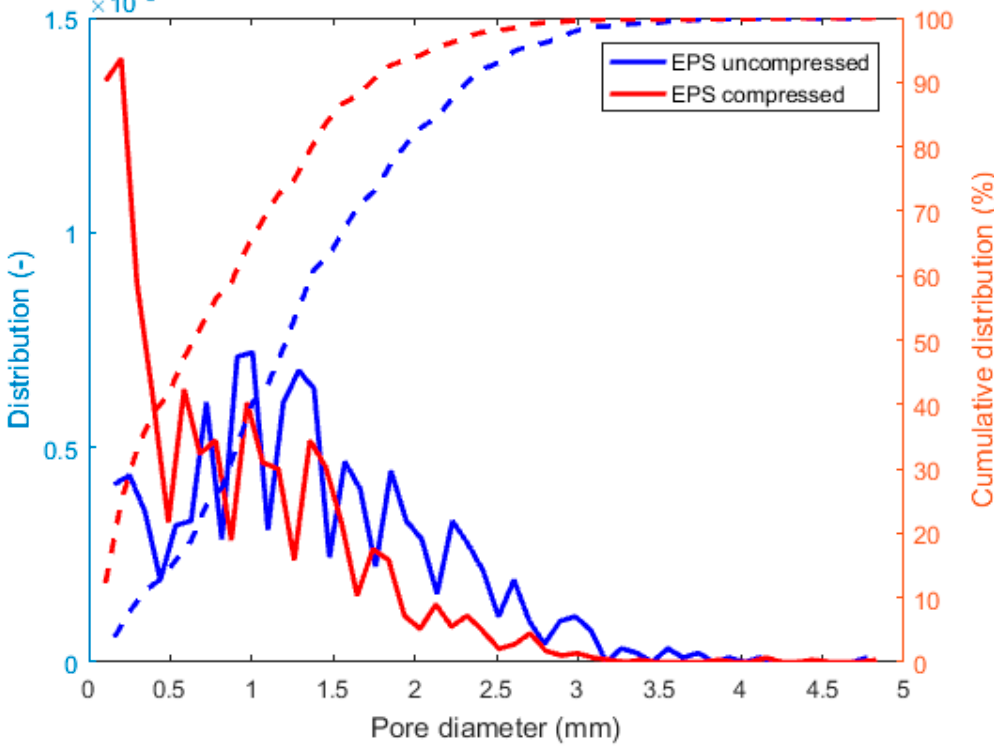
( b ) Figure 8. ( a ) Individualization of the different EPS beads, visualized by artificial color code in the compressed sample, and ( b ) bead size distribution for uncompressed and compressed EPS.